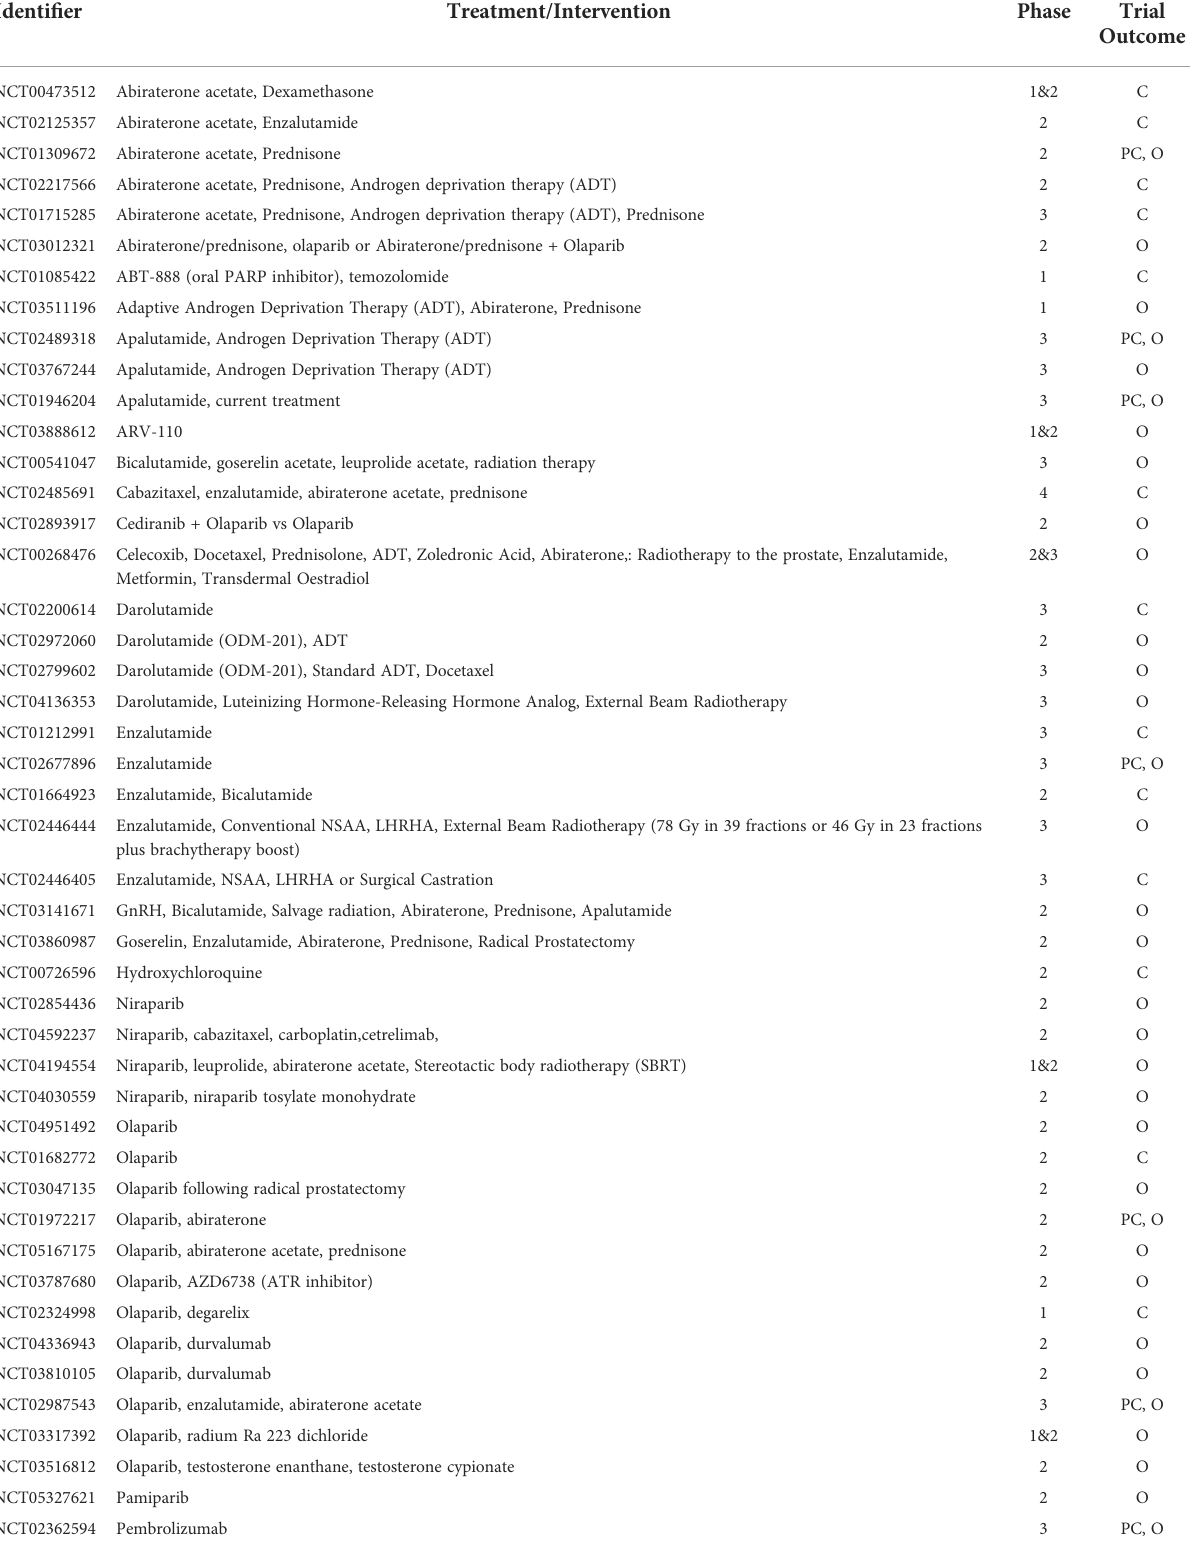
TABLE 1 Ongoing androgen deprivation and targeted therapies and clinical trials in prostate cancer – ordered by drug